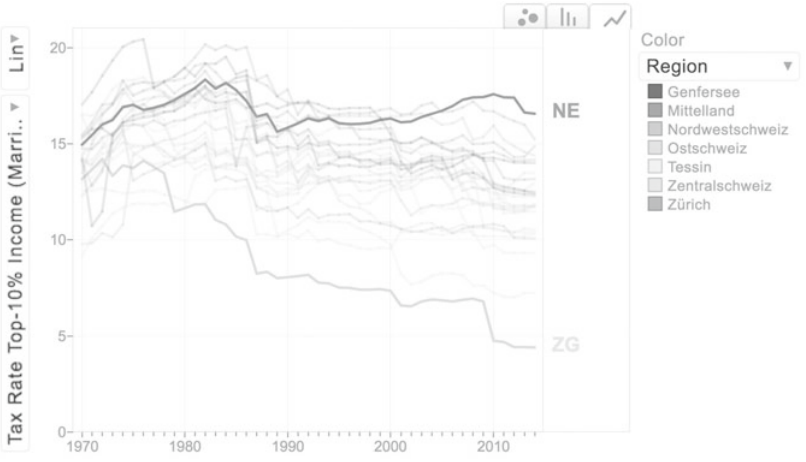
Figure 12: Evolution of consolidated cantonal + municipal effective average tax rate for a married couple without children and top-10% income across Swiss cantons from 1970 to 2014. Average across municipalities weighted by the number of